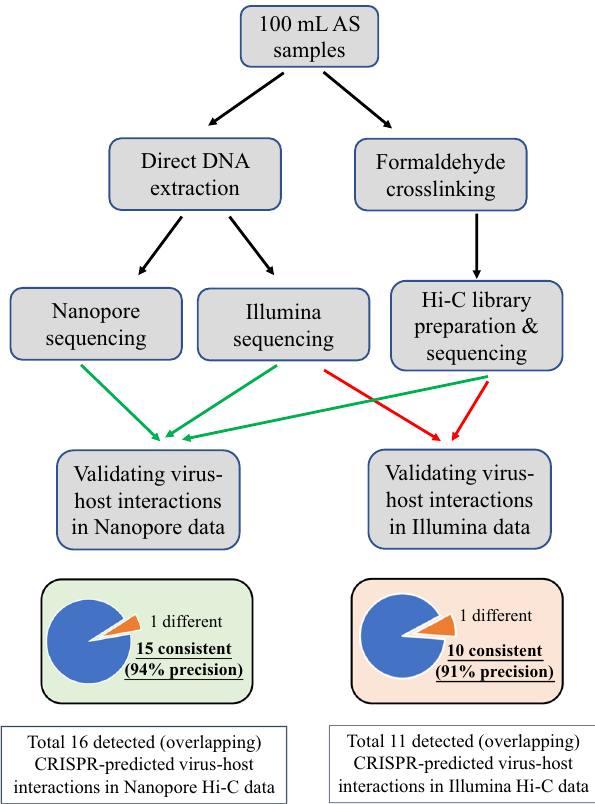
Fig. 7 General work fl ow to validate the precision of CRISPR-based methods in the present study. For Illumina data, 91% precision was observed. For Nanopore data, 94% precision was observed. Source data are provided as a Source Data fi